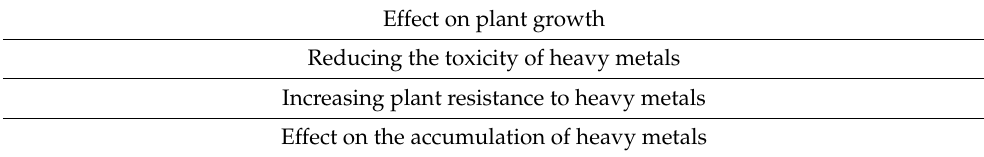
Table 1. Possible influences of microorganisms on plants in phytoremediation technologies.